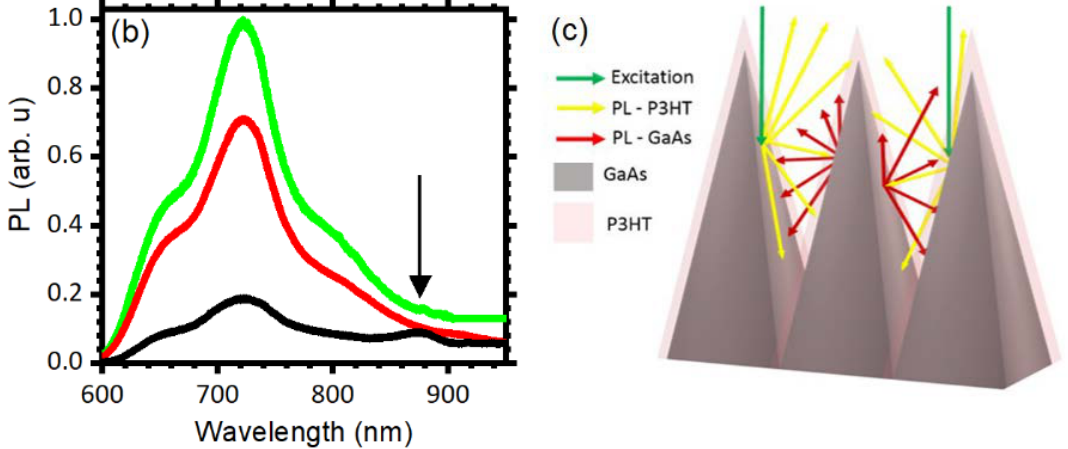
Figure 5. ( a ) Reflectance spectra collected for polished (red) and etched (black) GaAs (111)B surfaces covered with a P3HT thin layer. ( b ) Photoluminescence spectra collected for a P3HT film cast on a quartz substrate (green line), on polished GaAs (red line), and on black GaAs (black line). ( c ) Scheme of photon recycling at the black GaAs – P3HT